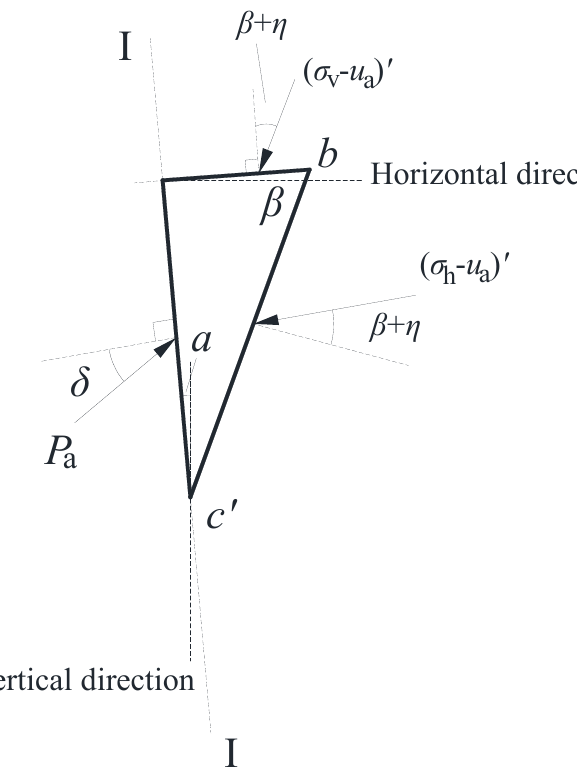
Figure 3. The stress analysis for the intensity of earth pressure. According to the mechanical equilibrium state in horizontal direction,